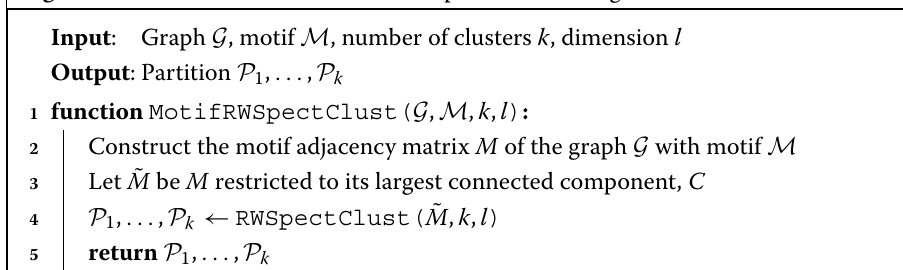
Algorithm 2: Motif-based random-walk spectral